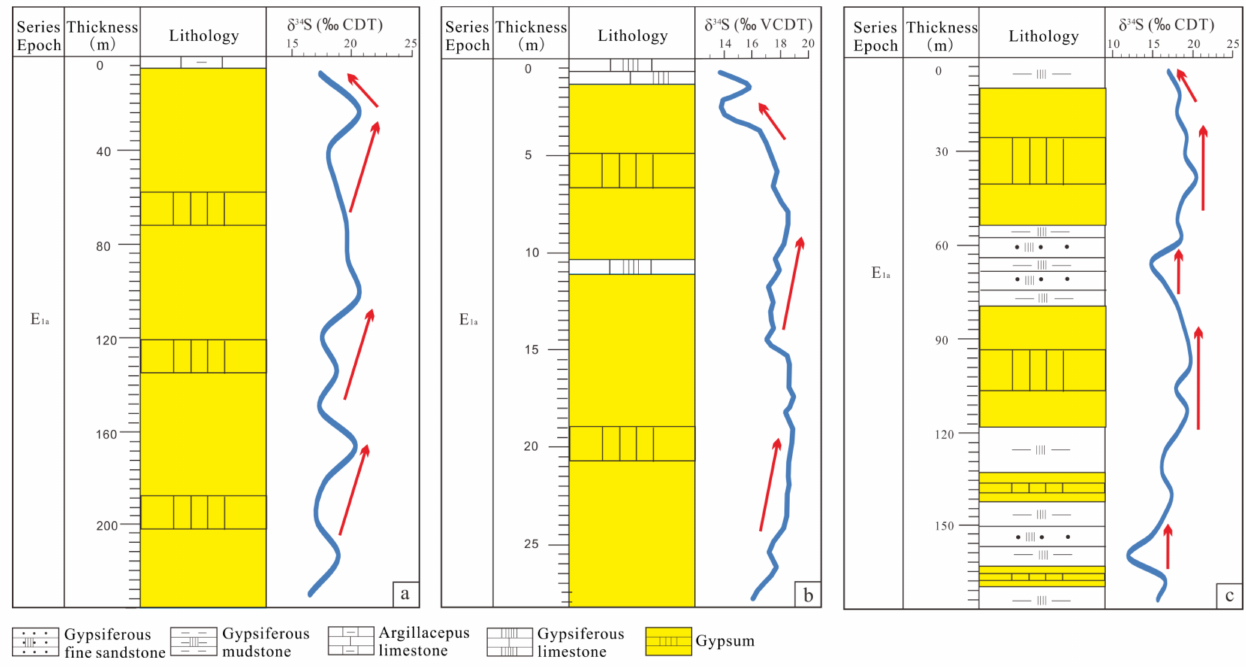
Figure 4. The sulfur isotopic curve of marine gypsum in the Yarkand Basin in the Paleocene. ( a ) AET profile; ( b ) KLY profile; ( c ) DSK